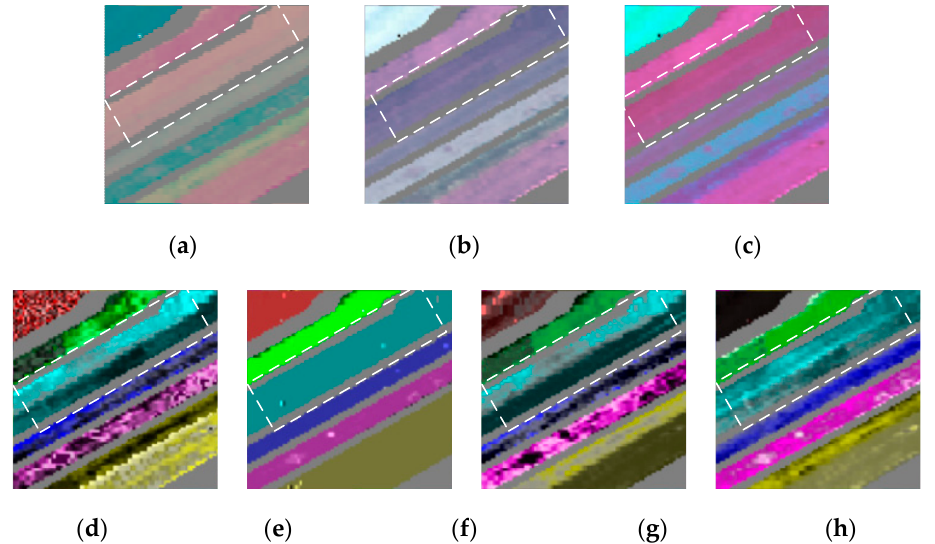
Figure 8. Visualization results for SalinasA. ( a ) PCA; ( b ) CMF; ( c ) band selection; ( d ) T-SNE; ( e ) LTSA; ( f ) LE; ( g ) ISOMAP.